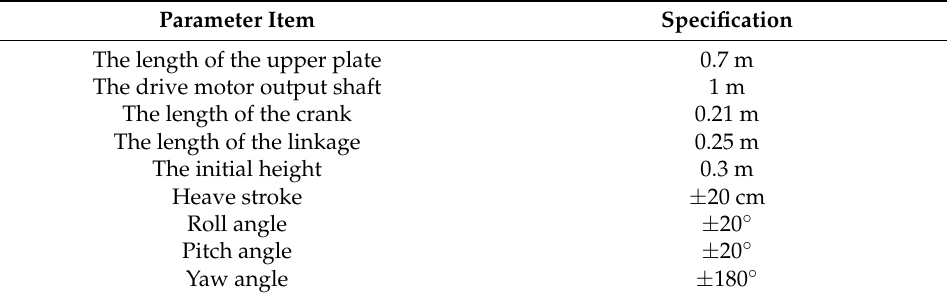
Figure 11. 3D design drawing of multi-axis motion platform. Table 2. The multi-axis motion platform specifications.